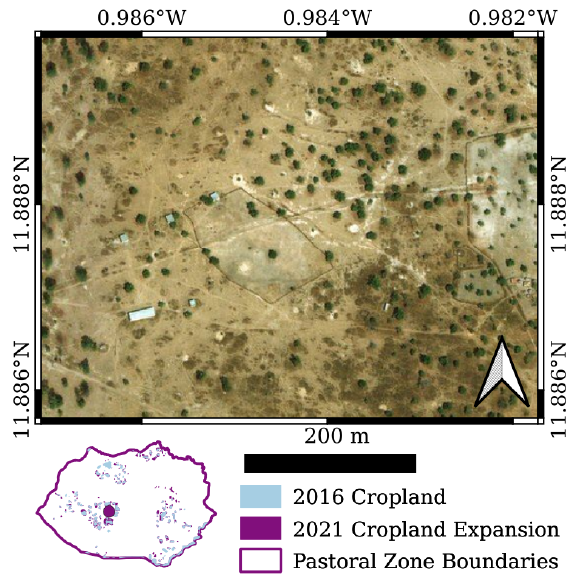
Figure 9: Aerial image of a settlement near a cluster of cropland in Sondre Est (source: Bing Aerial), EPSG 4326